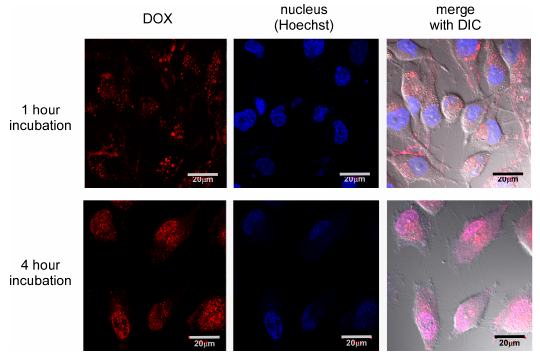
Figure 4. Intracellular distribution of DOX molecules loaded into SS-bonded nanocapsules after 1 h and 4 h incubation periods.